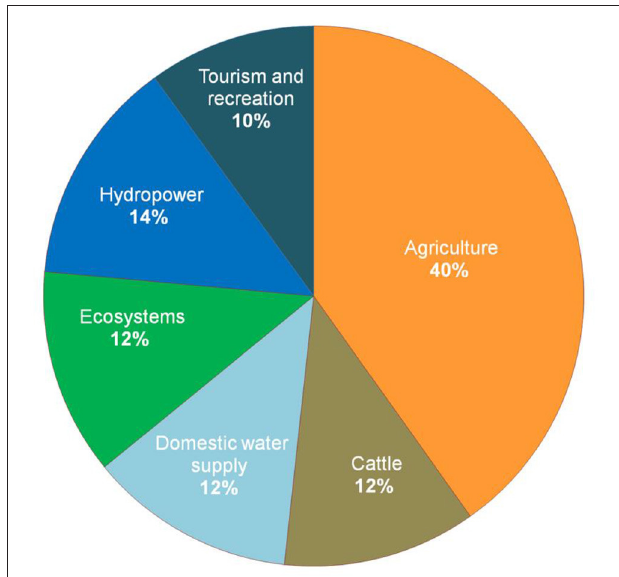
FIGURE 10 | Pie chart showing the proportion of articles published in local media (expressed as percentage) describing the impacts of the recent hydrological drought conditions over CWA for each of the main affected sectors.